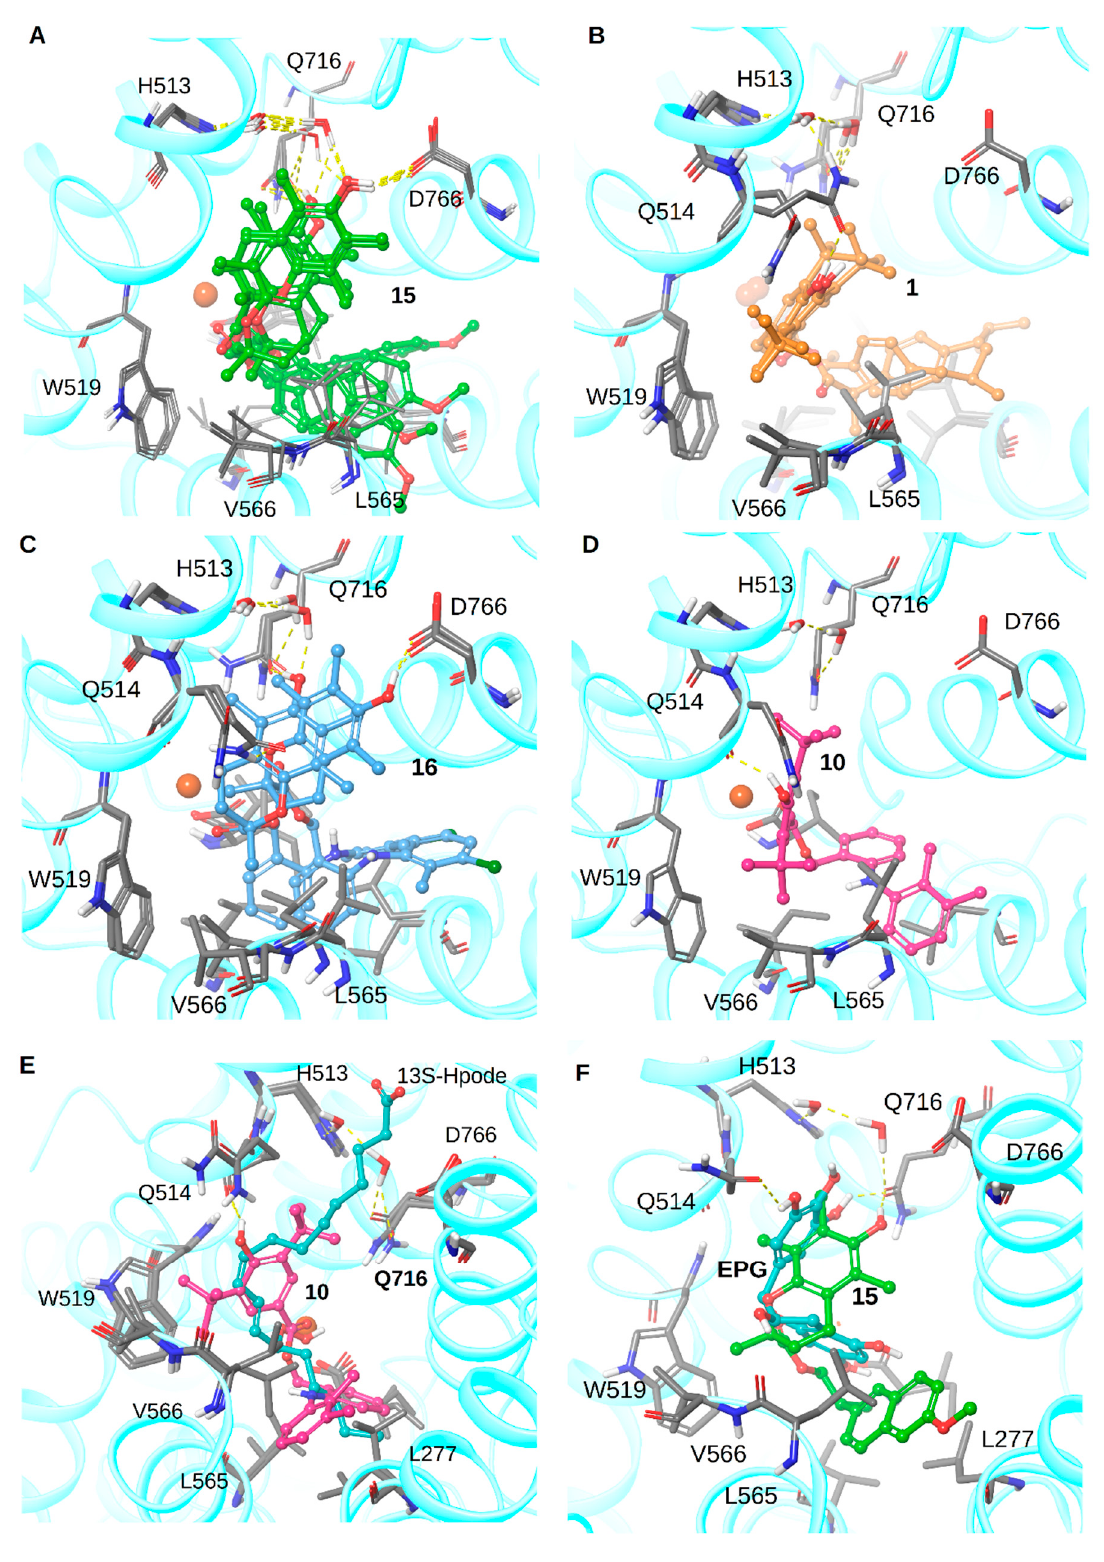
Figure 5. Docking poses of compounds 15 ( A ), 1 ( B ), 16 ( C ), and 10 ( D ) in the binding pocket of LOX-3. Superimposed docking pose of compound 10 and crystallographic binding mode of 13S-Hpode (original PDB entry) ( E ) and superimposed docking pose of compound 15 and crystallographic binding mode of EPG (original PDB entry) ( F ) as seen in the same binding pocket. Hydrogen bonds are depicted with yellow dashed lines.